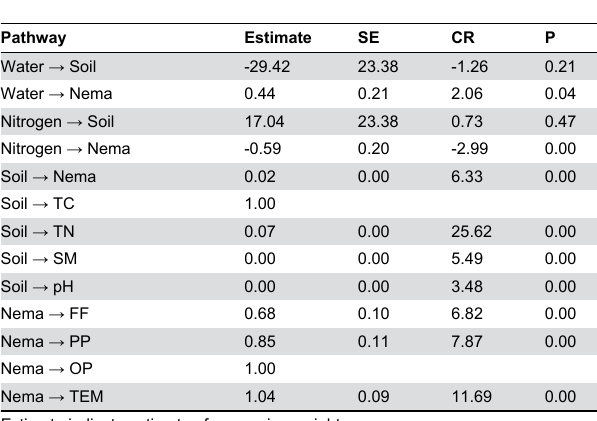
Table 3. The SEM model results showing the estimates, standard errors (SE), critical ratio (CR) and the P value.